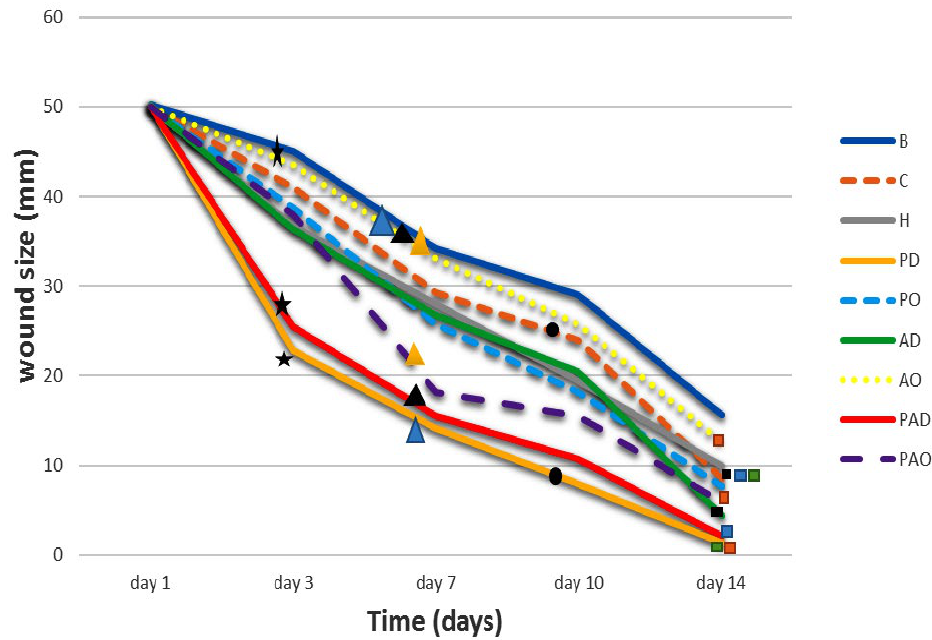
Figure 14. The wound healing rates based on wound sizes in different mouse groups. C: Control, B: Untreated infected wounds, H: Hydrogel, PD: Phage (daily), PO: Phage (once), AD: Antibiotic (daily), AO: Antibiotic (once), PAD: Phage-Antibiotic (daily), PAO: Phage-Antibiotic (once). According to the figure, the wound sizes of all the groups were not significantly different from each other on day one. indicates that the wound size of group AO was significantly different from those of groups PD and PAD on day 3 of the treatment ( p < 0.05). indicates that on day 7 of the treatment, the wound size of the AO group was significantly different to those of the PD, PAD and PAO groups ( p < 0.01). indicates that the wound sizes of groups C and PD were significantly different on day 10 of the treatment ( p < 0.01). Based on the analysis, the wound size of the group C was significantly different from those of groups AD, PAD and PD, and the wound size of group AO was significantly different from those of groups PD and PAO on day 14 of the treatment ( p < 0.01).